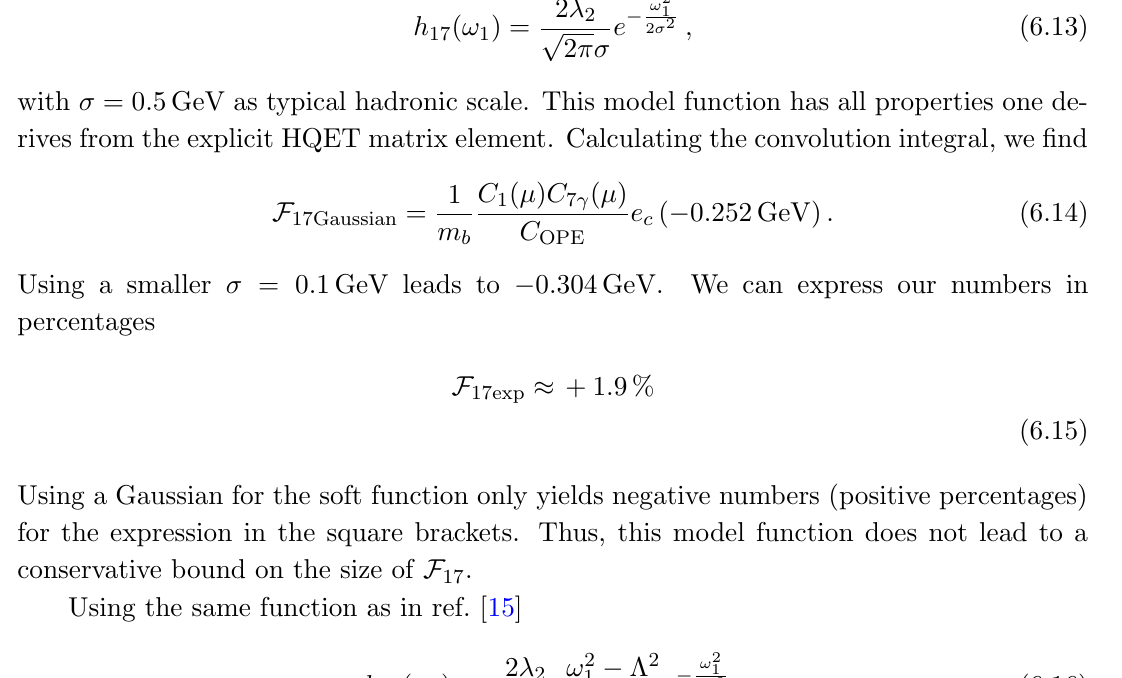
2 Figure 9 . J = 1 GeV 2 and q 2 17 for q min tion